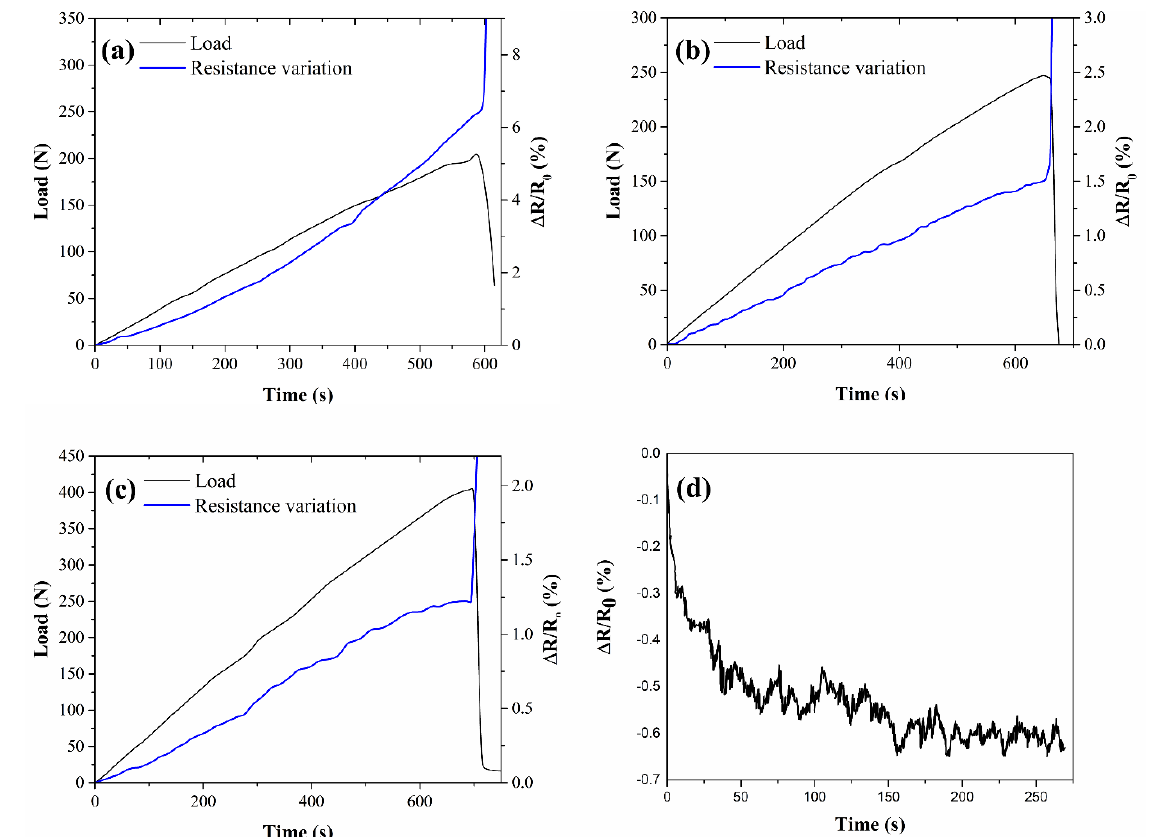
Figure 5. Self-monitoring behavior of ( a ) CB6_1, ( b ) CNT0.75_1, and ( c ) CNT1_1 under monotonic bending tests; and ( d ) electrical acquisition of CNT0.75_1 in the unloaded state.